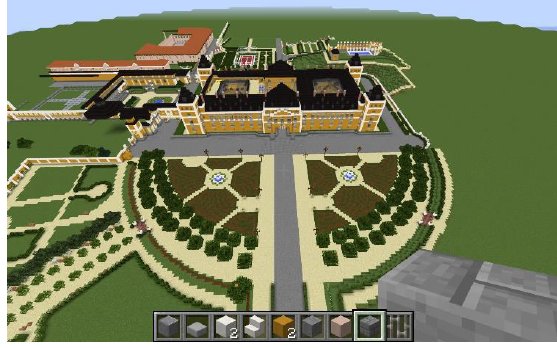
Figure 3. El Pardo. 3D